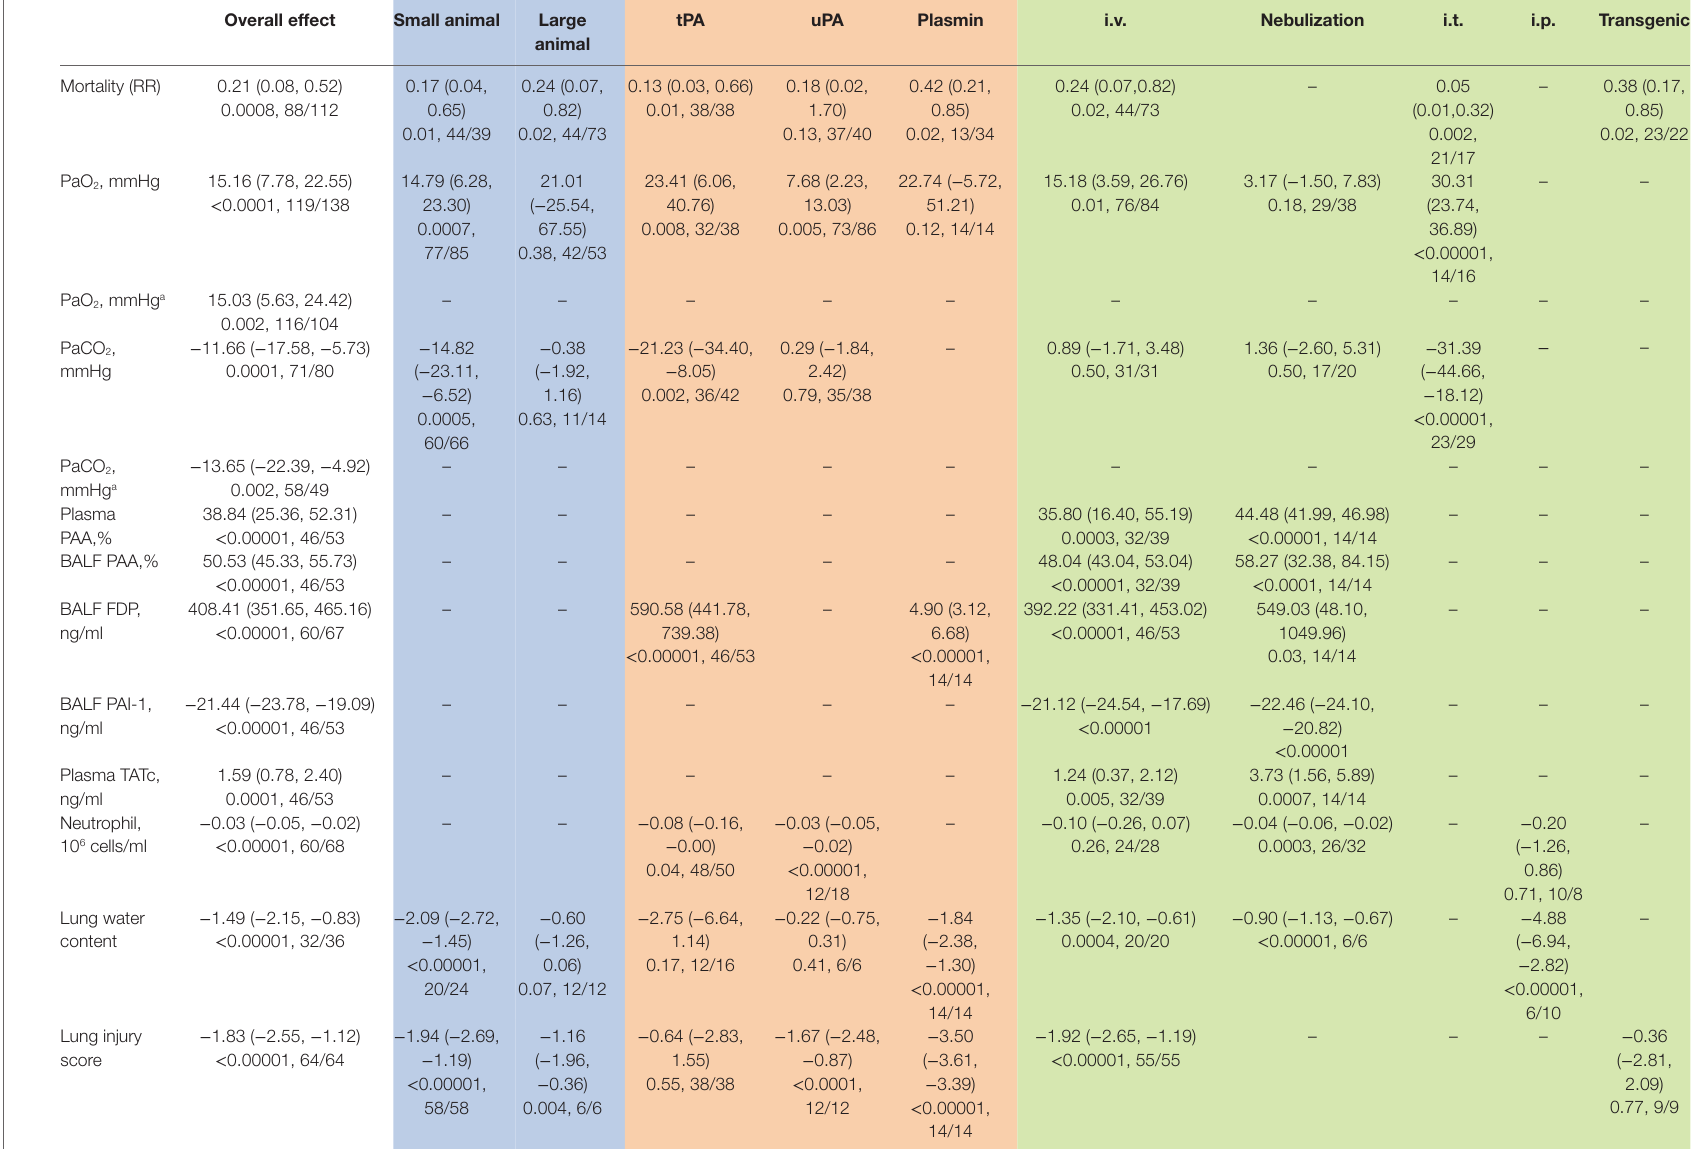
taBLe 4 | Summary of analyzed parameters.